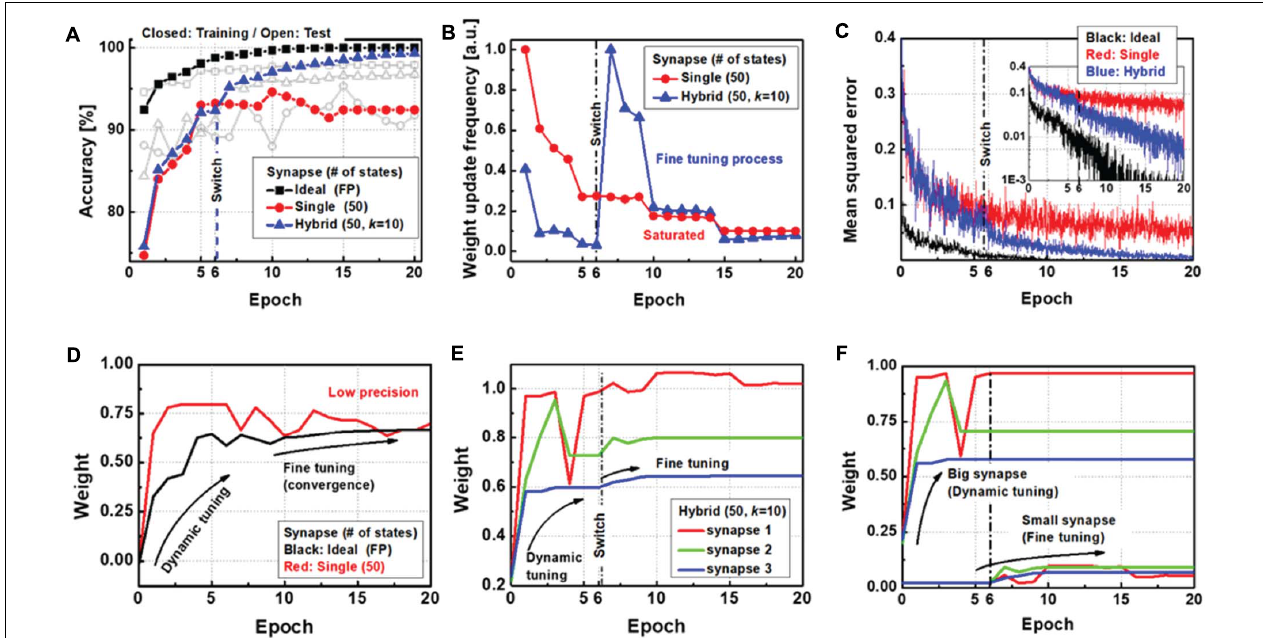
FIGURE 4 | (A) Evolution of training and test accuracies, (B) weight update frequency response, and (C) mean squared error (MSE) of the neural networks as a function of the training epoch for each type of synapse implementation. (D) Weight history of the ideal synapse shows dynamic tuning followed by fine tuning with precise adjustments, whereas a single synapse with a low precision device cannot be precisely adjusted. (E) Weight history of the hybrid synapse as a function of training epoch. (F) Separated weight history for each precision synapse in a hybrid synaptic